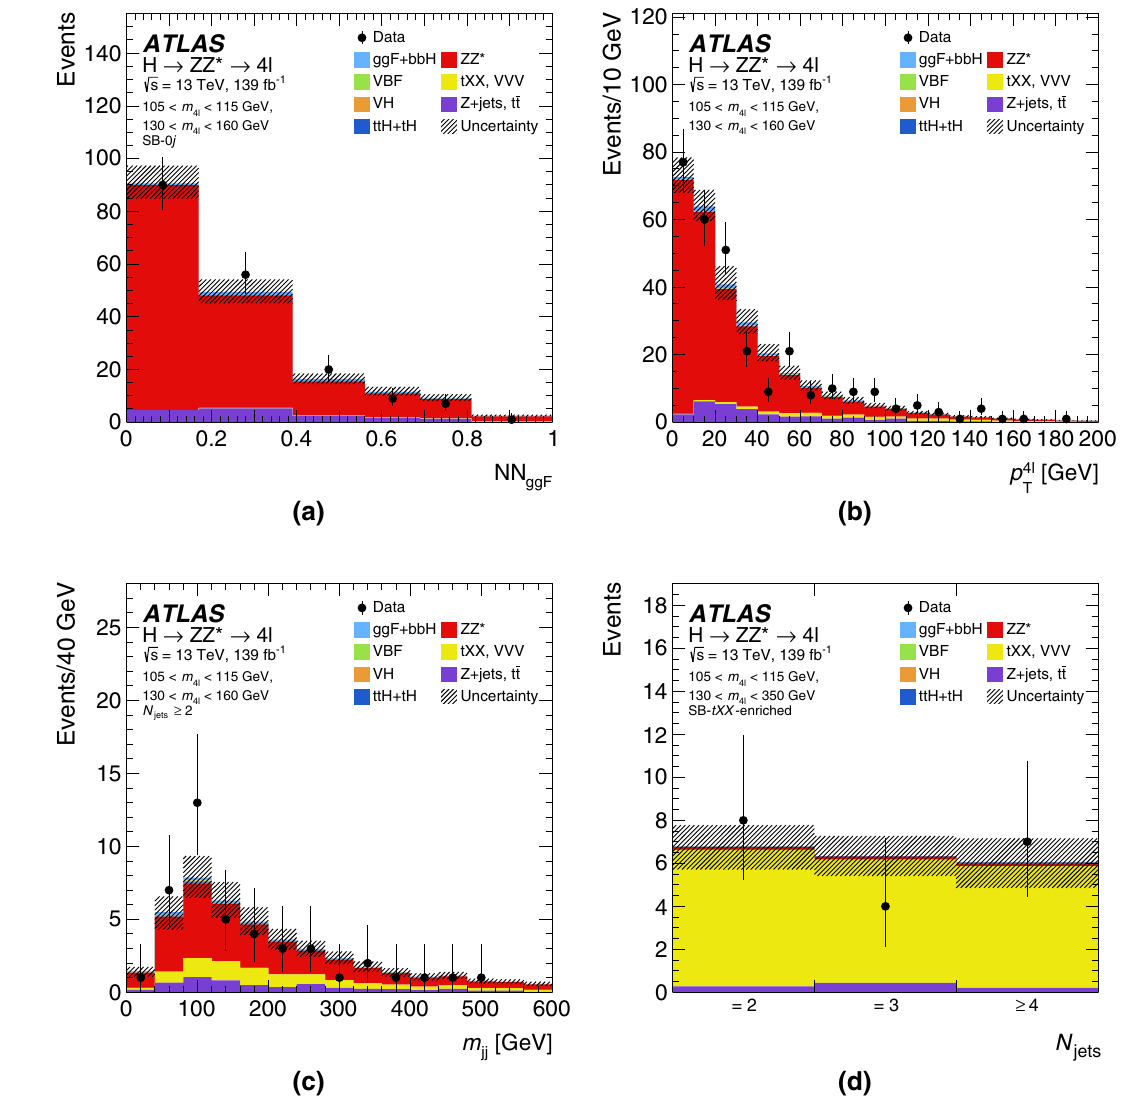
Fig. 4 The observed and expected (post-fit) distributions for an inte- √ grated luminosity of 139 fb − 1 at s = 13 TeV in the different back- ground enriched regions: ( a ) NN ggF in the SB-0 j sideband region, ( b ) p 4 (cid:4) in the sideband region combining the SB-0 j , SB-1 j and SB-2 j T categories, ( c ) m jj in the SB-2 j category, and ( d ) N jets in the SB- tX X